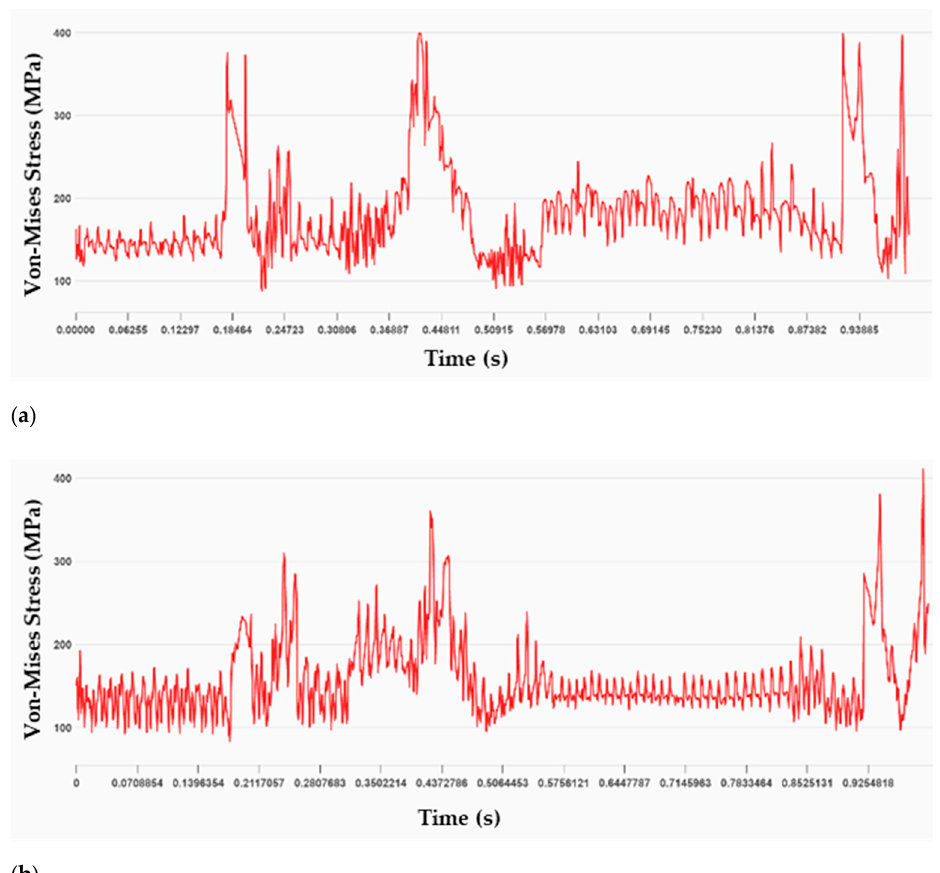
Figure 18. Stress distributions during one revolution of the driving and driven gears. ( a ) Driving gear and ( b ) Driven gear.